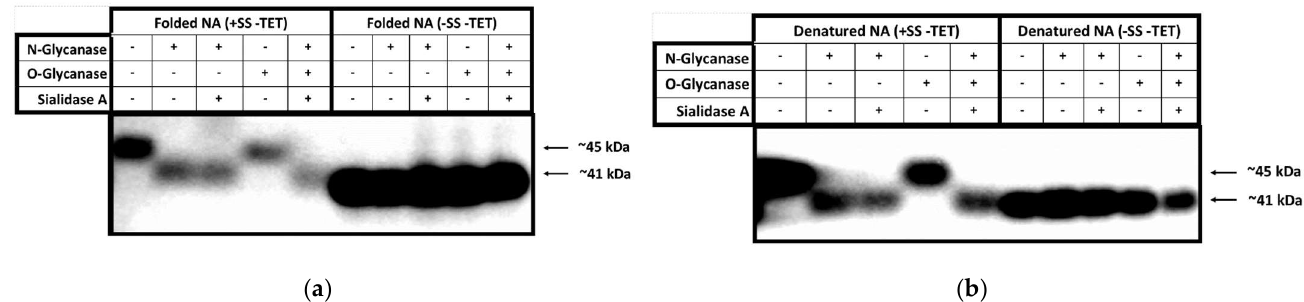
Figure 3. HEK NA deglycosylation analysed by Western blot. ( a ) The supernatant of a pTT5-NA (+SS − TET) and lysed pellet of pTT5-NA ( − SS − TET) were digested with deglycosylation enzymes The digested proteins were separated by SDS-PAGE, transferred to PVDF membrane for analysis by Western blot. An anti-His antibody was utilised to visualize the NA proteins. ( b ) Proteins were denatured prior to deglycosylation, and then deglycosylated and analysed on WB in the same way as in panel